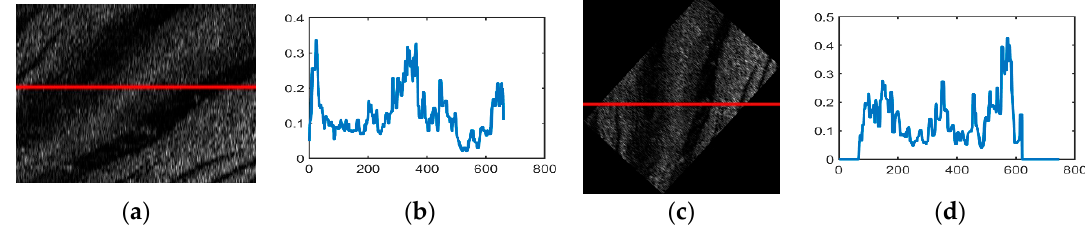
Figure 16. Geometric correction example. ( a ) Raw SSS imaging. ( b ) Raw echo intensity values. ( c ) SSS imaging after geometric correction. ( d ) Echo intensity values after geometric correction.